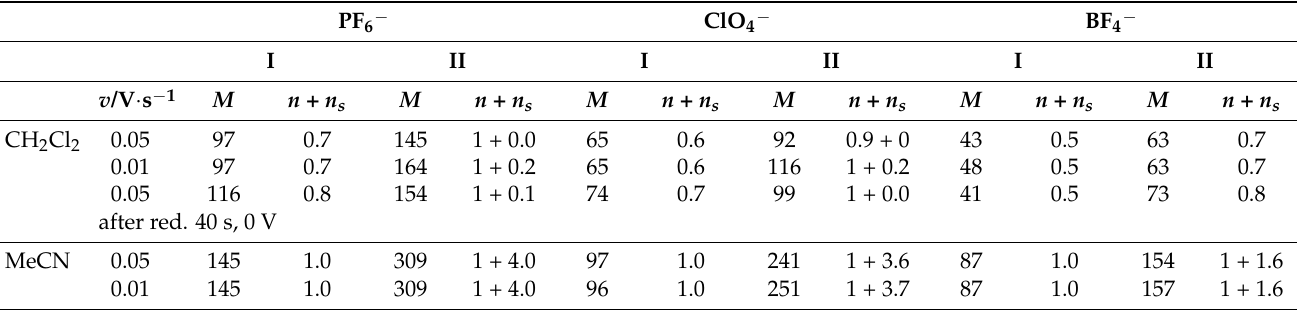
Table 1. Molar mass ( M /g · mol − 1 ) obtained from the slopes of ∆ m = f( Q ) plots and molar